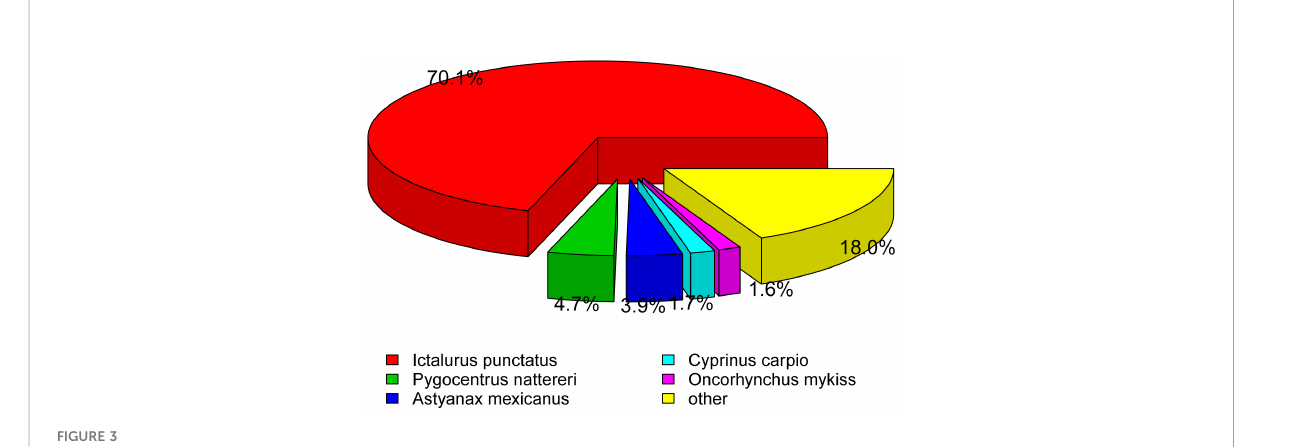
FIGURE 3 Map of species distribution in the NR database.